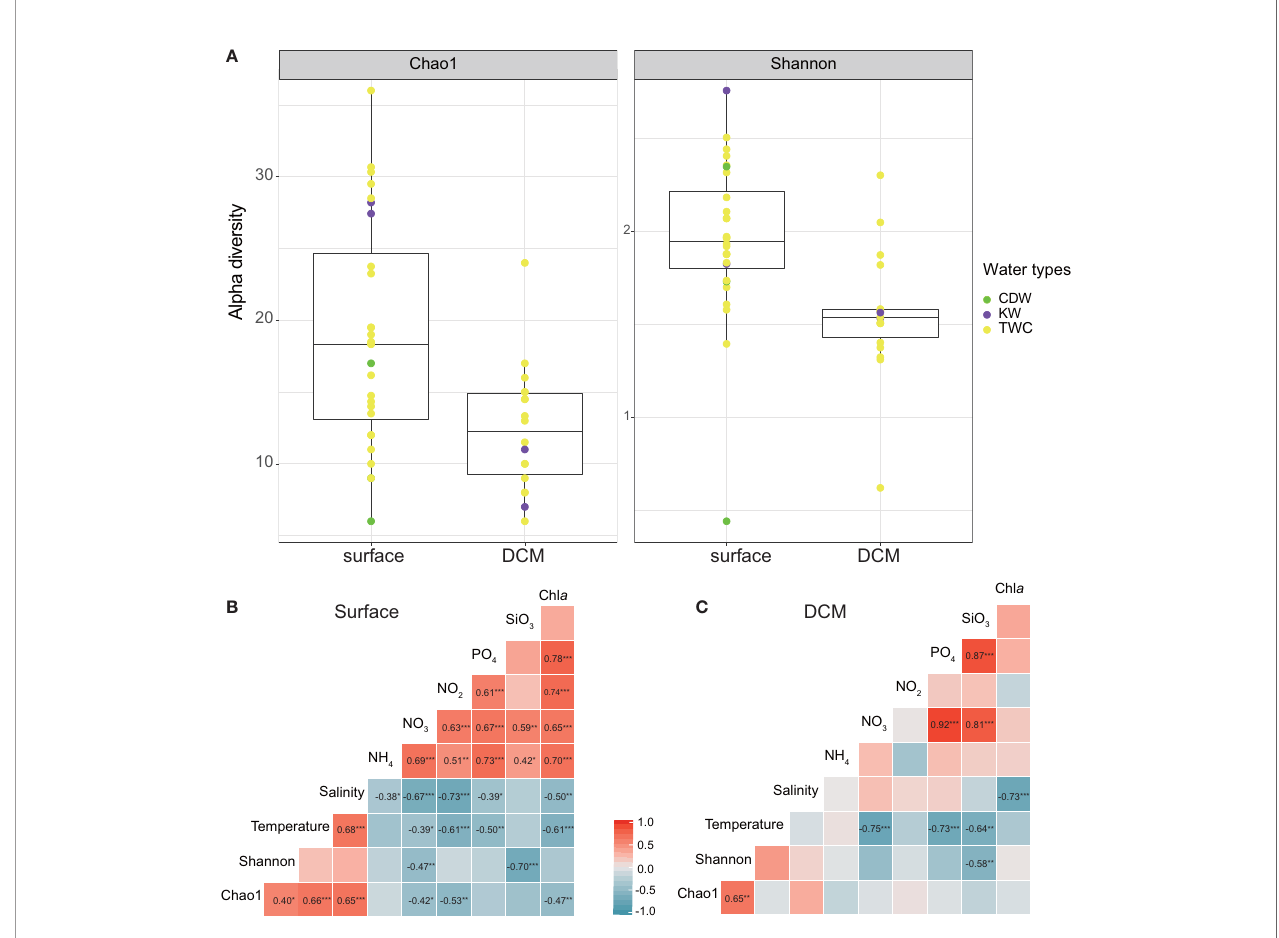
FIGURE 4 | (A) Comparison of chlorophyte diversity in surface and DCM samples. Subsampling data was calculated using Chao1 and Shannon diversity, and is represented as box-whisker-plots with median values as horizontal lines, and interquartile ranges as boxes with whiskers extending to 1.5 times the interquartile range. The de fi nition of water masses is based on Gong et al., 1996. Green indicates the Chiang Dilution Water (CDW); purple indicates the Kuroshio Water (KW); and yellow indicates the Taiwan Warm Current (TWC). (B, C) Pearson ’ s correlation coef fi cients between diversity indices and environmental variables for (B) surface data and (C) DCM data. The colors indicate the strength of positive (red) and negative (blue) coef fi cients, and *, ** and *** indicate statistical signi fi cance at P < 0.05, <0.01 and 0.001,